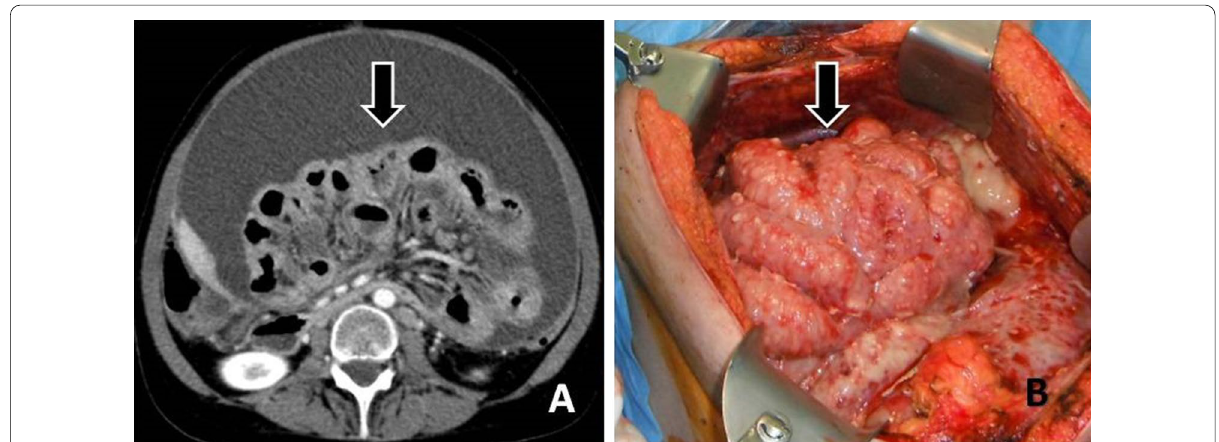
Fig. 15 a Contrast enhanced CT image demonstrates shrinkage and distortion of the mesentery—“frozen mesentery”—(arrow) along with irregular thickening of the wall of intestinal loops (“layered-type” involvement of small bowel). b The extensively involved mesentery and intestinal loops are seen as a "cauliflower" mass at surgery (arrow)